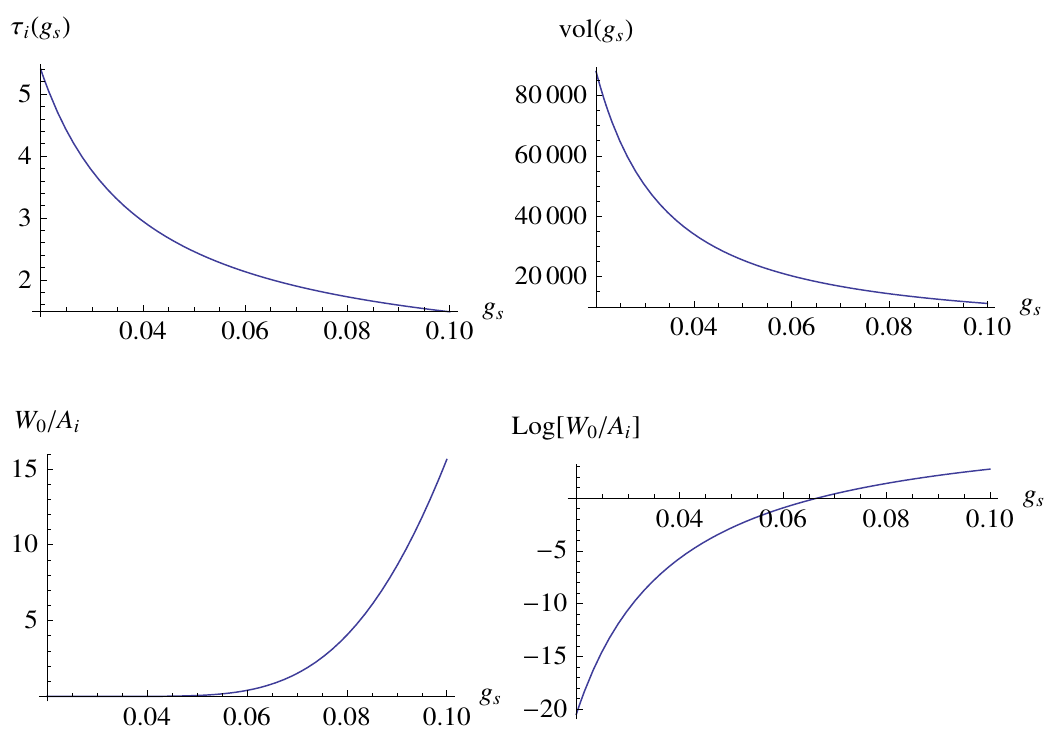
Figure 5 . Values of (cid:28) s ,